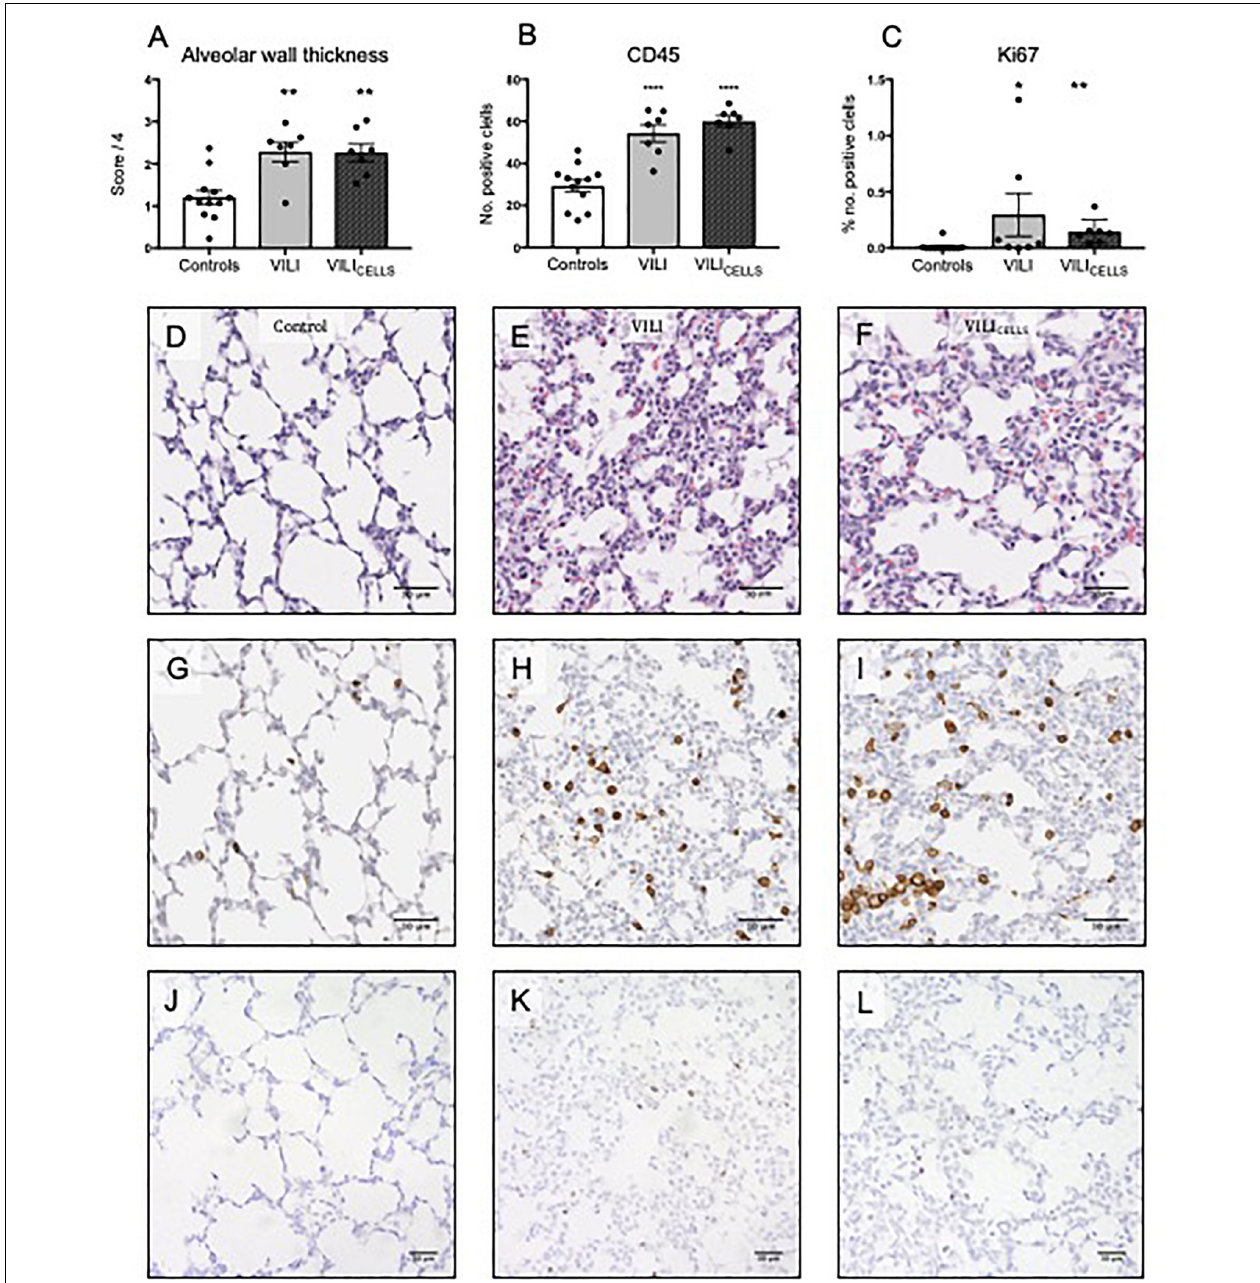
FIGURE 3 | (A) Alveolar wall thickness expressed a score out of 4, (B) Immune cell infiltration expressed as the number of positive cells per field of view, (C) number of proliferating cells expressed as the percentage of positive cells. Scale bars show 50 µ m. * P < 0.05, ** P < 0.01, **** P < 0.0001 compared to controls. (D–F) Representative lung sections stained with Hematoxylin and Eosin to assess alveolar wall thickness in (D) control, (E) VILI, and (F) VILI CELLS lambs. (G–I) Representative lung sections demonstrating immune cell presence using CD45 immunohistochemistry. (J–L) Representative lung sections demonstrating cellular proliferation using Ki67 immunohistochemistry. Scale bar shows 30 µ